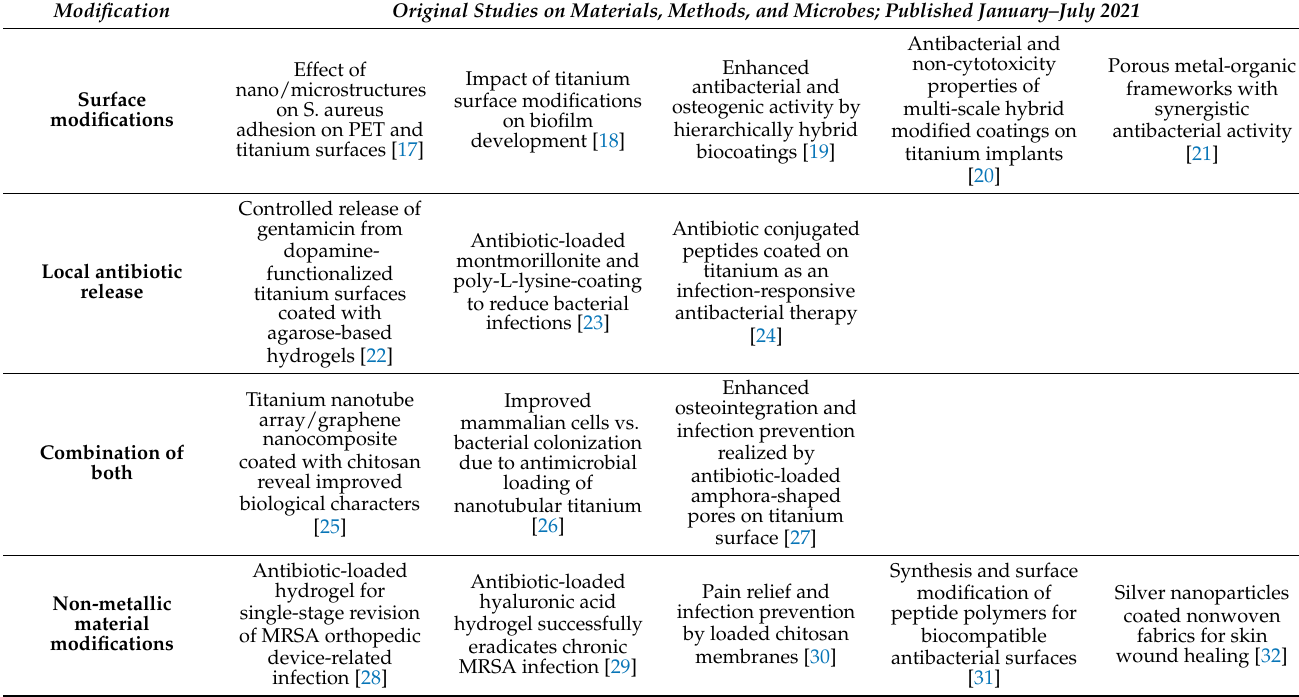
Table 2. Summary of the 16 original studies.